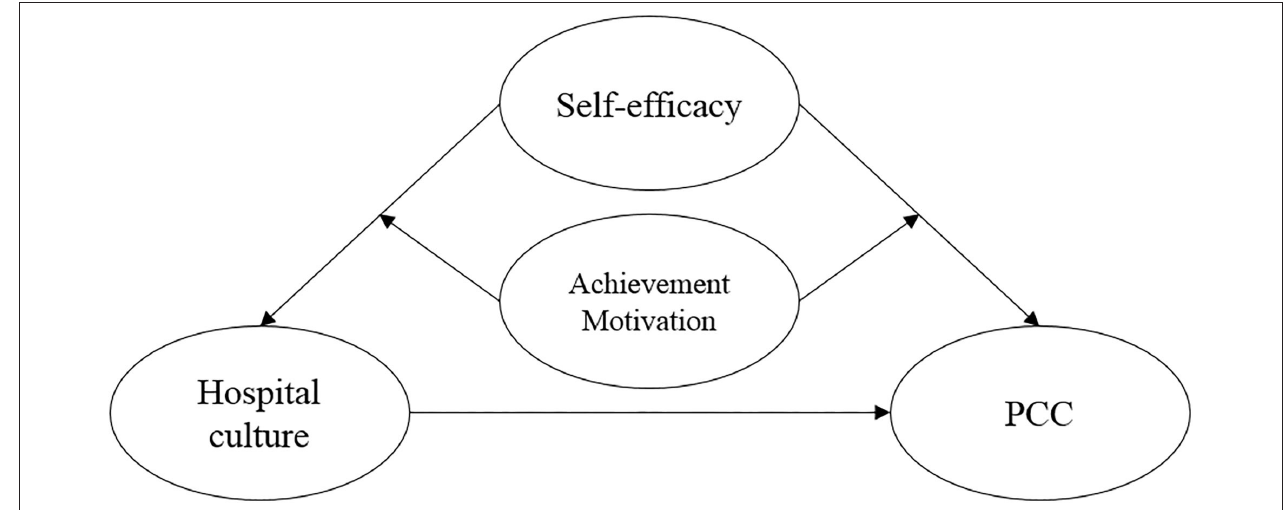
FIGURE 1 | sResearch model diagram of healthcare workers’ patient-centered